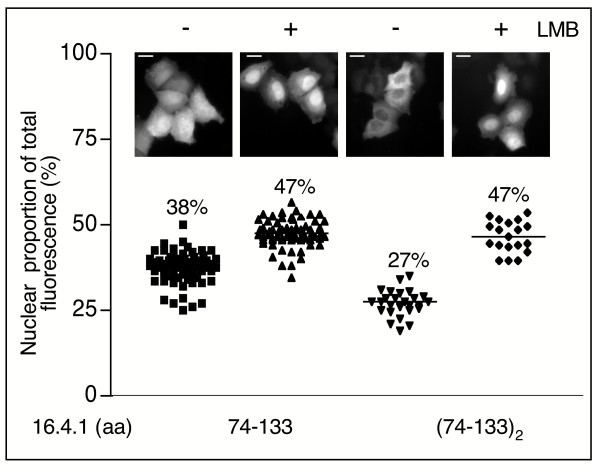
Analysis of CRM1-dependent nuclear export of amino acid region 74 to 133 of 16.4.1. HeLa cells were transfected with plasmids directing expression of GFP fusion proteins containing 16.4.1 region 74–133 in single copy or in tandem (74–133)2. Representative images of the subcellular distribution of the GFP fusion proteins in untreated (-) and LMB treated cells (+) are shown at the top. Symbols in the graph indicate the nuclear proportion of fluorescence (%) in individual cells and horizontal lines and numbers the median of the cell population. Scale bars: 10 μm. Inhibition of CRM1 by LMB treatment increases nuclear proportion of GFP fusion proteins containing aa residues 74 to 133 of 16.4.1. GFP fusion proteins containing two copies of region 74 to 133 show stronger cytoplasmic localization than GFP fusion proteins with a single copy. These results indicate that region 74 to 133 of 16.4.1 is a substrate for CRM1-dependent export, which is recognized more efficiently in tandem than as a single copy.